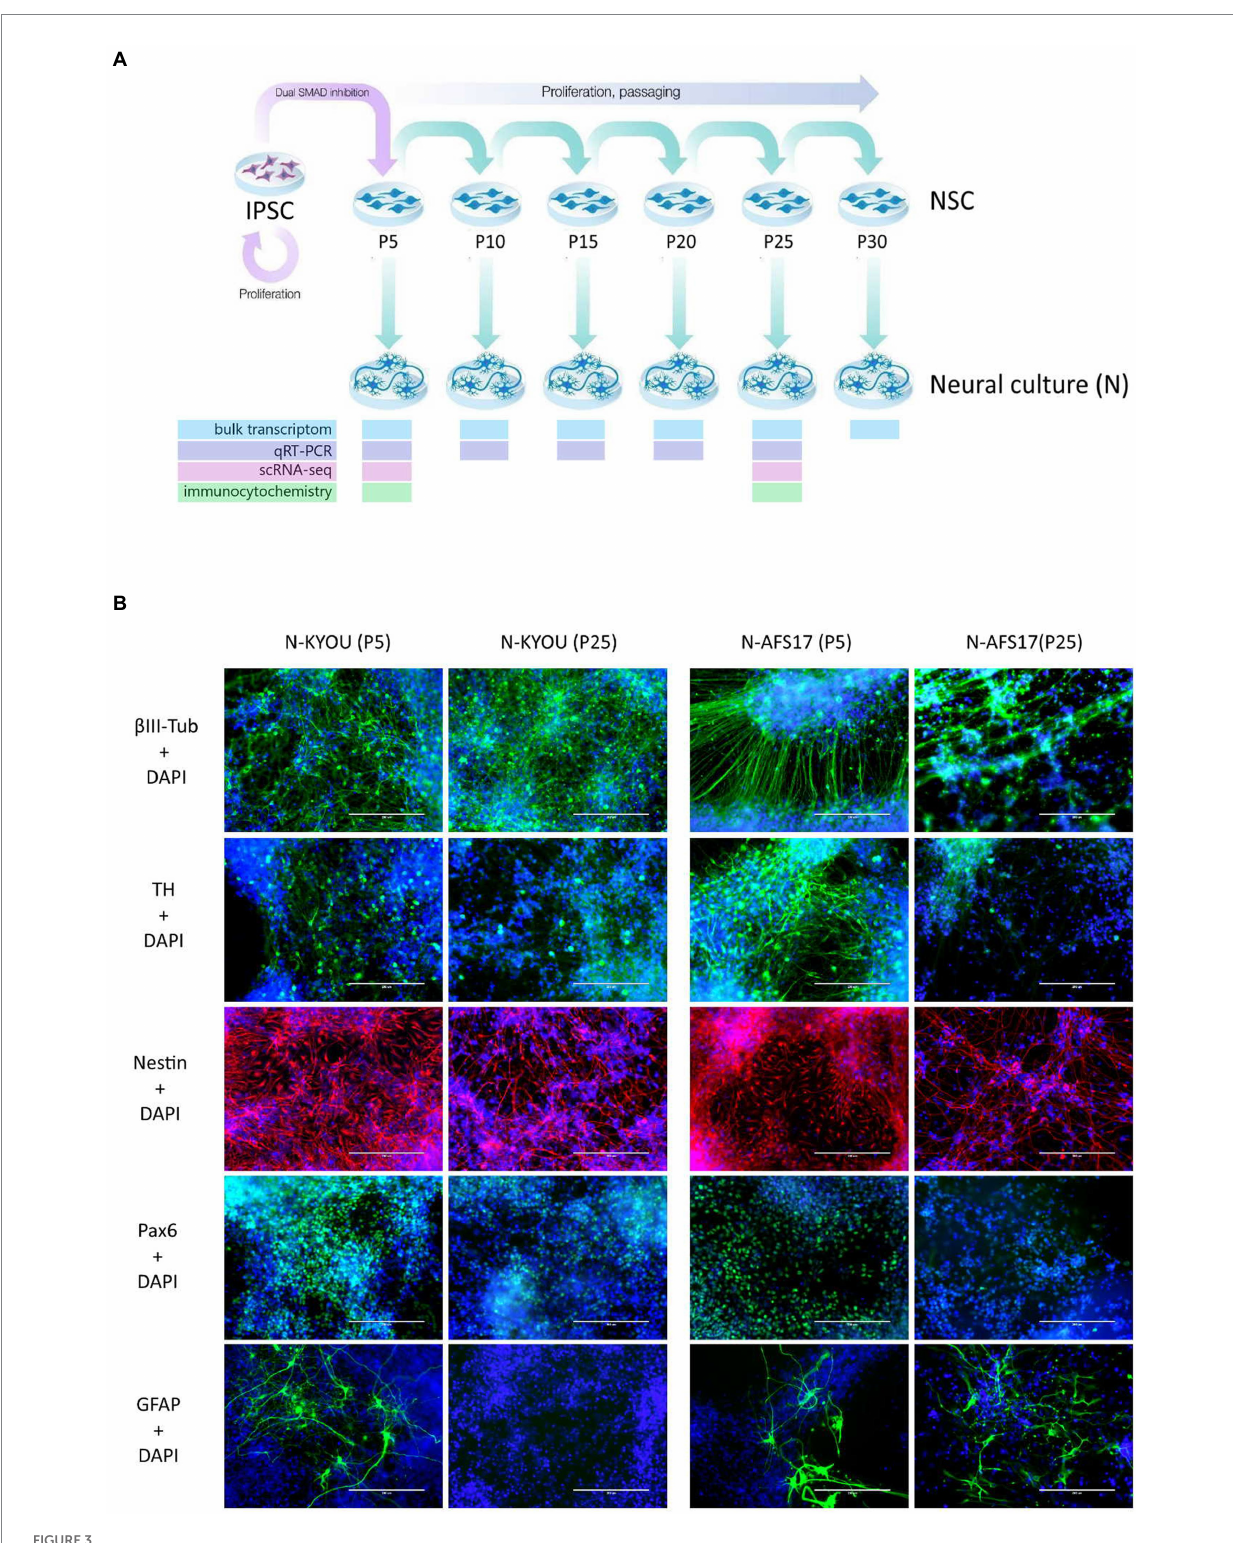
FIGURE 3 (A) General scheme of the experiment of investigate spontaneous differentiation of iPSCs into neurons. (B) Immunocytochemical staining of neural cultures at day 21 of spontaneous differentiation of N-KYOU and N-AFS17 at 5 and 25 passages (P). The cells were stained for neuron markers b-III- tubulin and tyrosine hydroxylase (TH), neuron precursor cell markers nestin and Pax6 and glial cell marker GFAP. Fluorescence microscopy, scale bar 200 μ